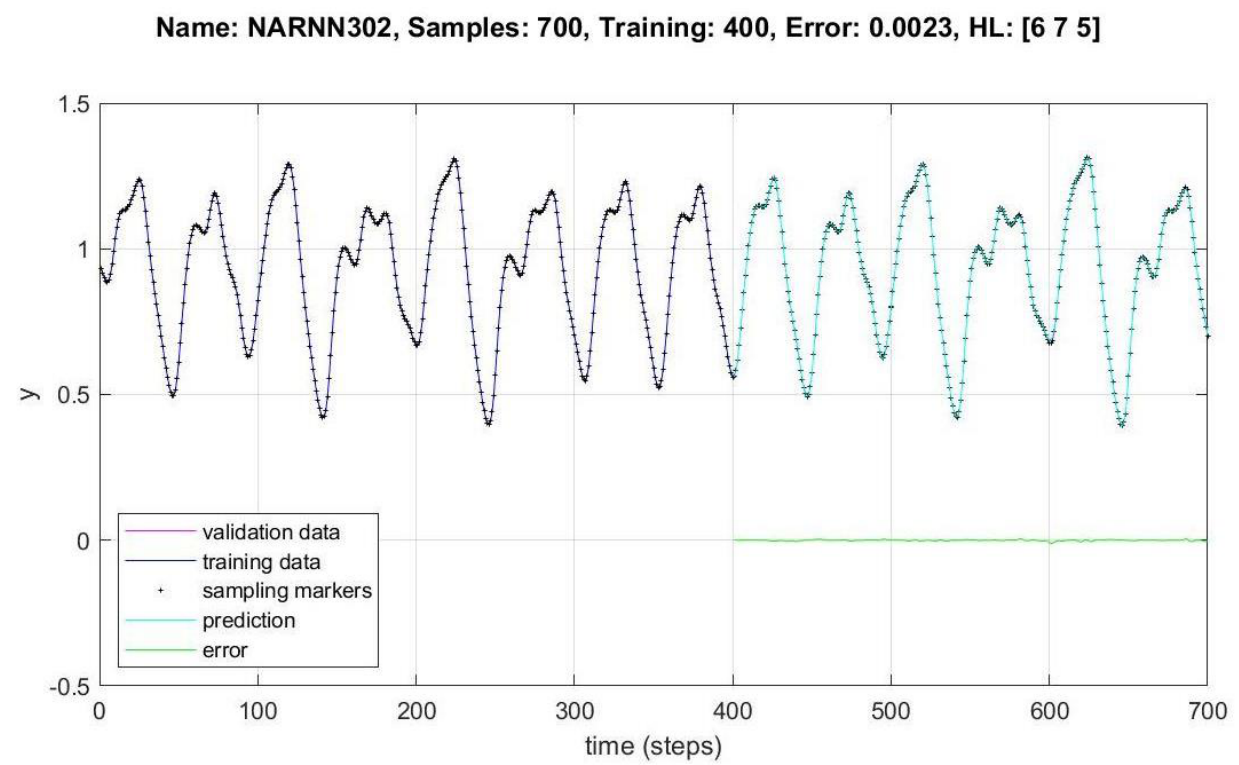
Figure 12. Performance of NARNN302 for 700 samples.